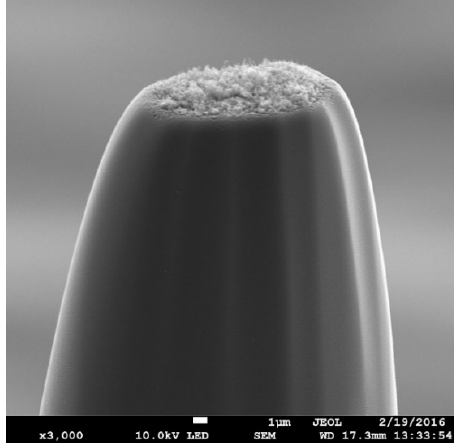
Figure 1. SEM image of the emitting tip surface of the porous glass-like nanomaterial.